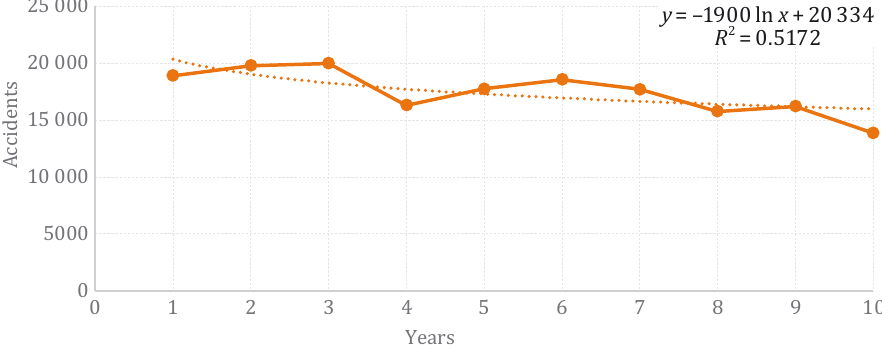
Figure 8. Number of accidents for the period of 2011–2020 associated with a logarithmic trend